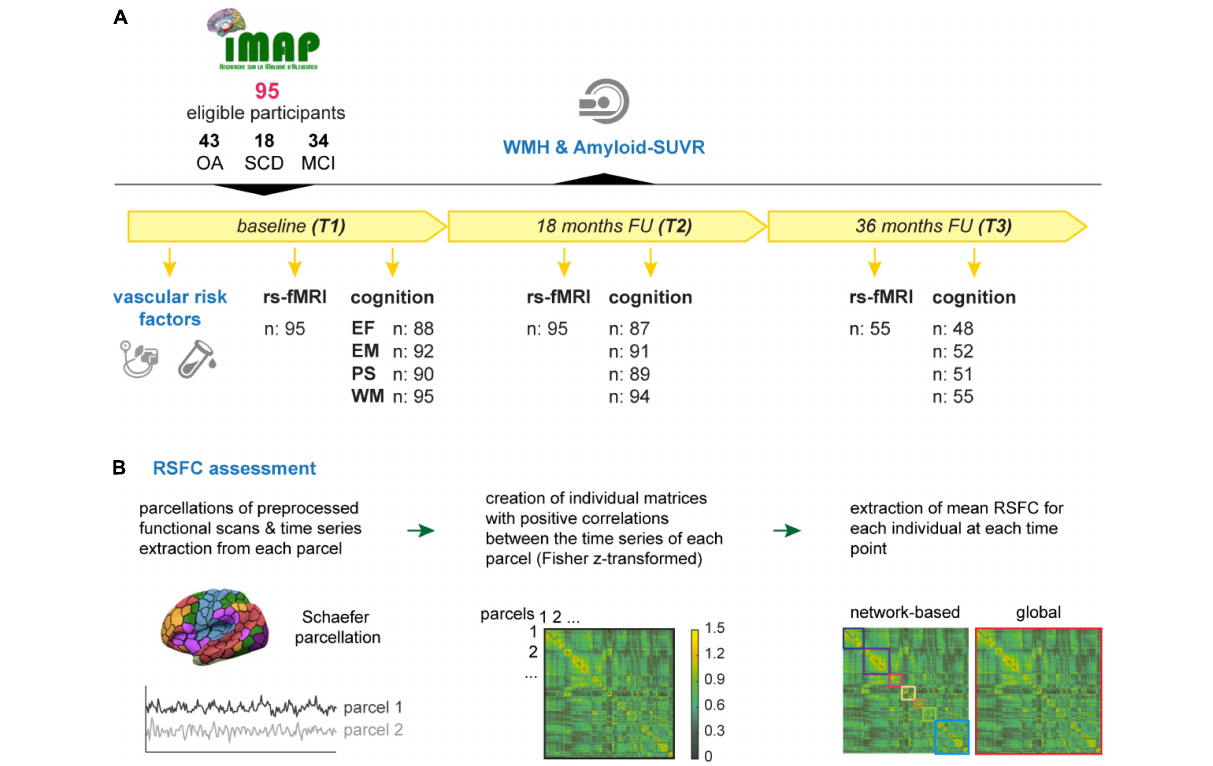
Frontiers in Integrative Neuroscience |